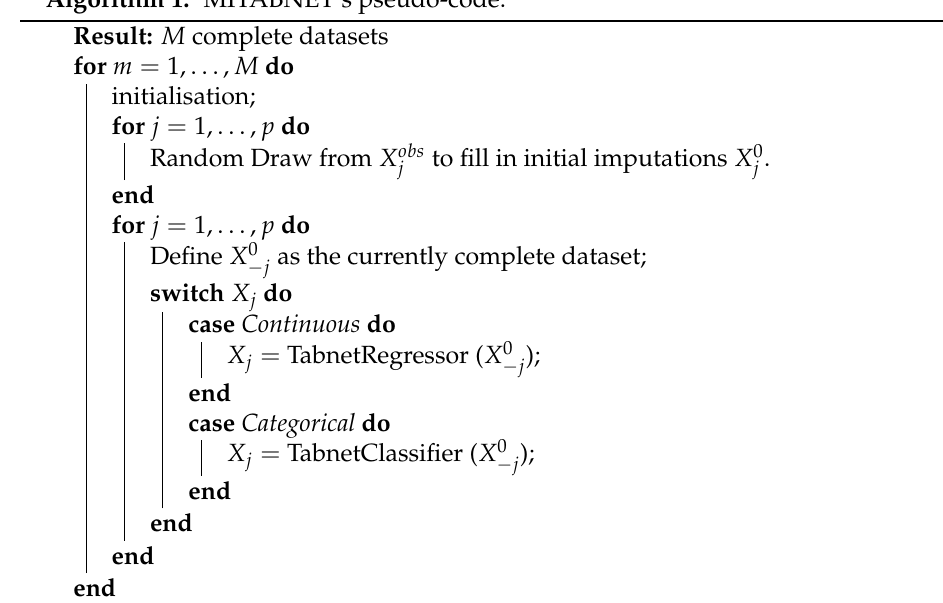
Algorithm 1: MITABNET’s